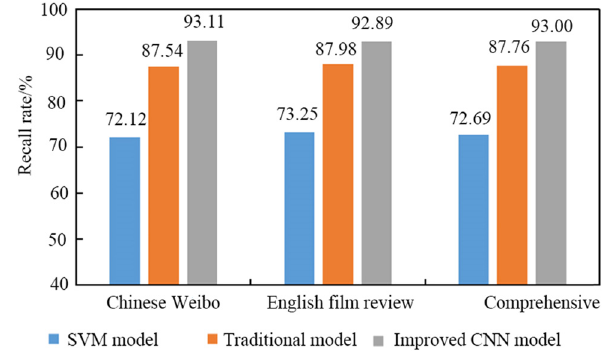
Figure 7: The recall rate of three classi fi cation models for text emotional tendency classi fi cation.